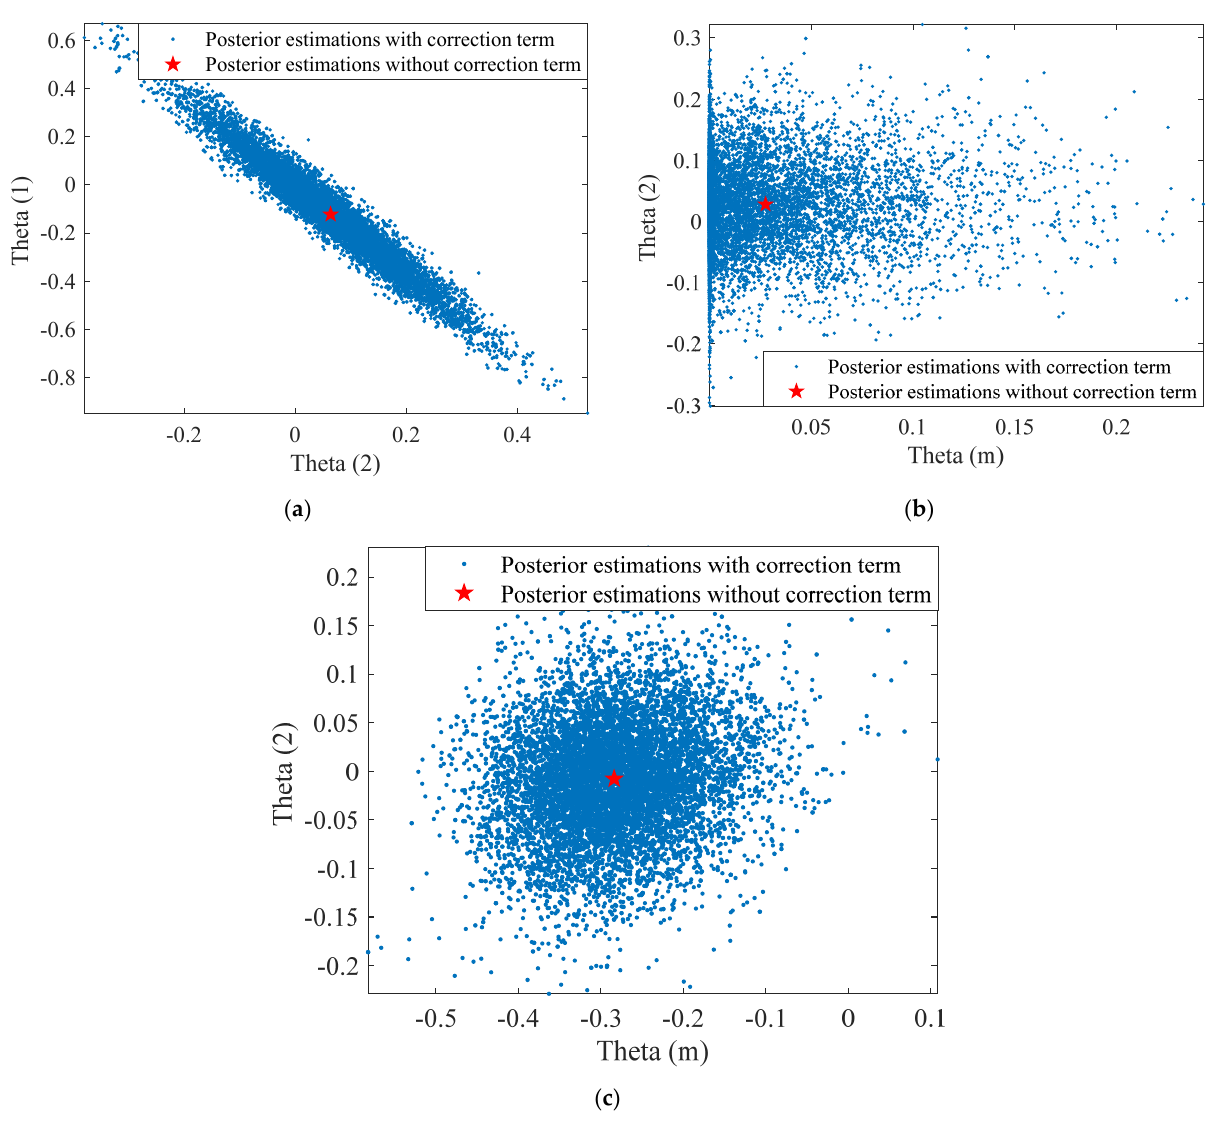
Figure 1. The posterior estimates of the unknown model parameters. ( a ) Model I. ( b ) Model II. ( c ) Model III.